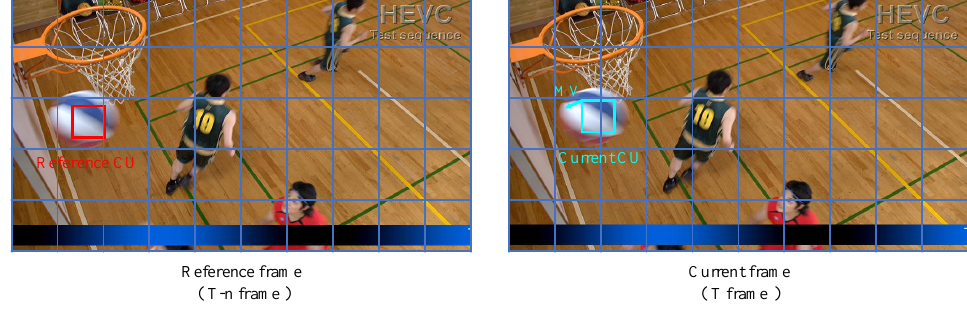
Figure 1. Inter prediction.